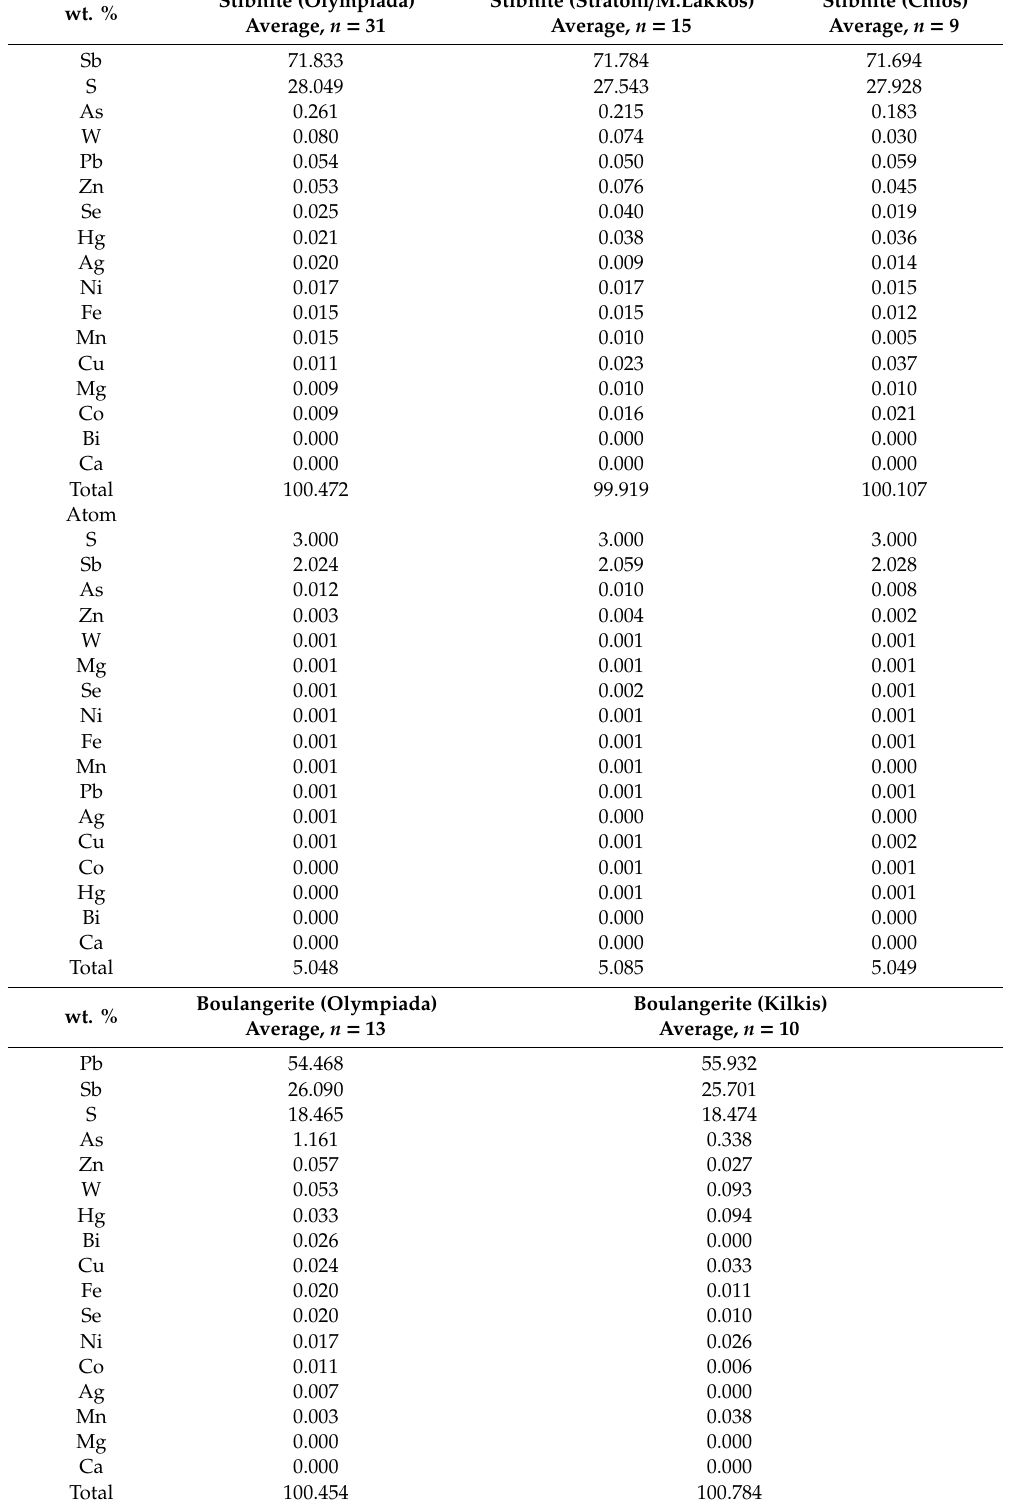
Table 1. EMPA point analyses of Sb minerals from